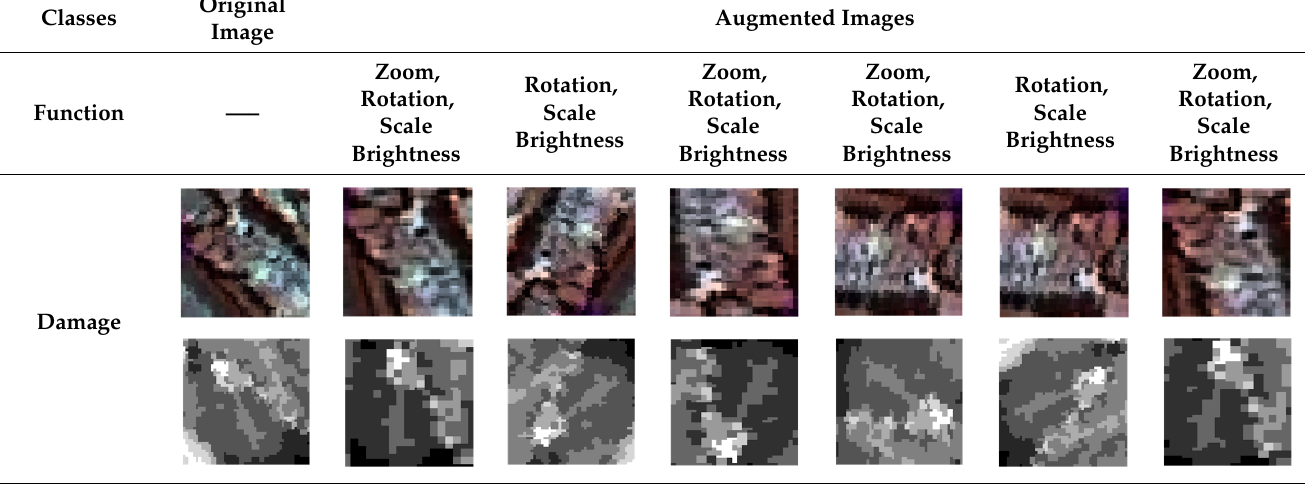
Figure 5. The proposed BDD-Net architecture for building damage detection.